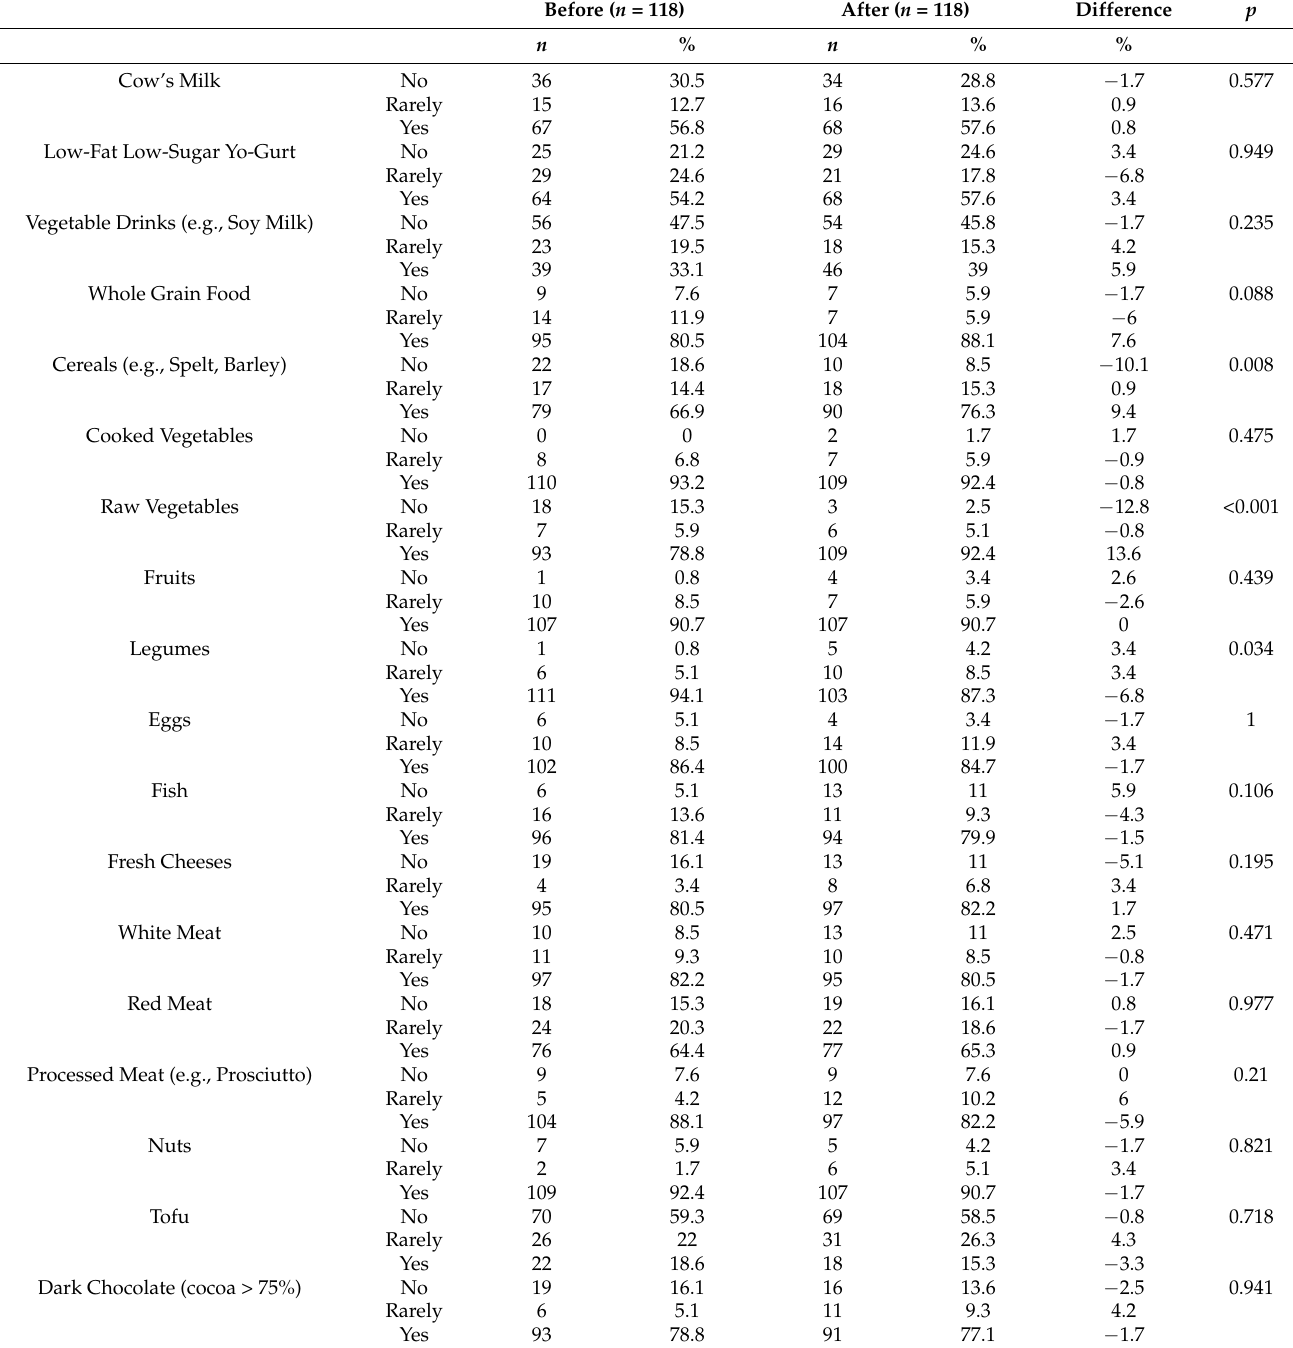
Table 2. Consumption frequency differences before and after COVID-19